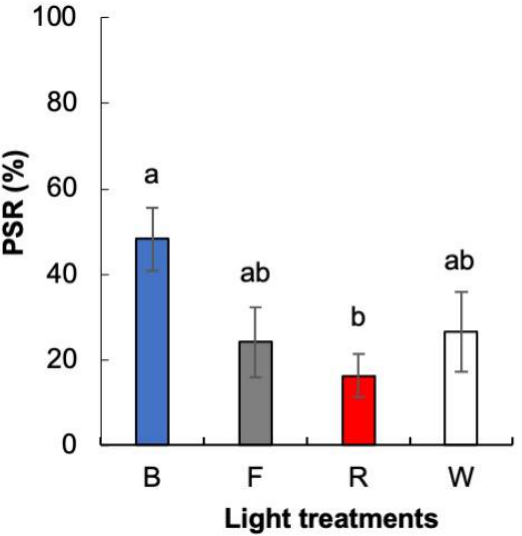
Figure 3. Percentage of shoots elongated enough to be rooted (PSR) of Pinus ponderosa growing on half LP macronutrients under light treatments (blue LEDs (B), fluorescent light (F), red LEDs (R), and white LEDs (W)). Data are presented as mean values ± S.E. Different letters indicate significant differences according to Tukey’s post hoc test ( p < 0.05). Table 1. Root induction (%), number of roots per explant, and length of the longest root of Pinus ponderosa shoots cultured in half LP macronutrients according to light treatment (blue LEDs, red LEDs, white LEDs, and fluorescent light). Data are presented as mean values ±